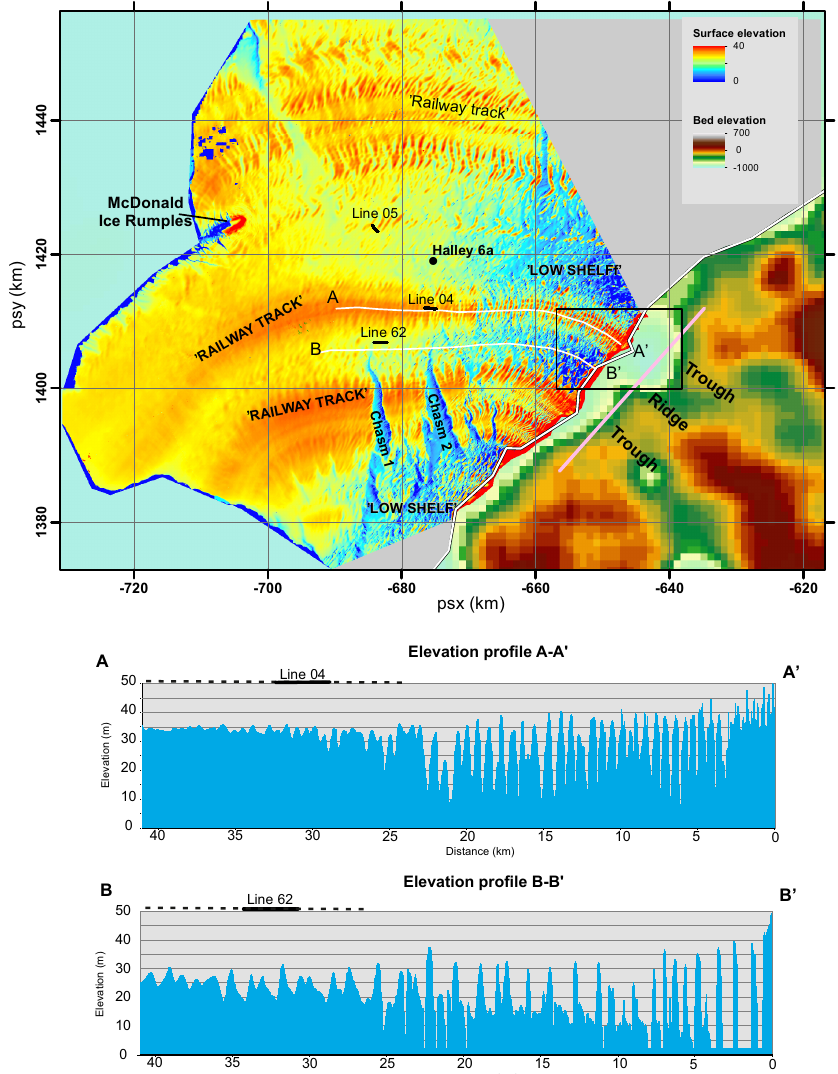
Figure 2. Surface elevation of the Brunt Ice Shelf and the bedrock elevation beneath grounded ice in Coats Land. Flow lines downstream from troughs in the bedrock have higher elevation throughout the ice shelf (orange colours). Near to the grounding line these elevated bands comprise closely spaced ridges resembling railway sleepers; hence we term the bands “railway tracks” for descriptive purposes. White lines show locations of elevation profiles extracted from the digital elevation model and shown below the map. Line locations in continuous black mark sections of radar profiles shown in Figs. 4 and 5 (dashed black lines over profiles show full extent of profiles). Pink line is location of flow speed profile shown in Fig. 3. Box is the extent of the satellite image shown in Fig.